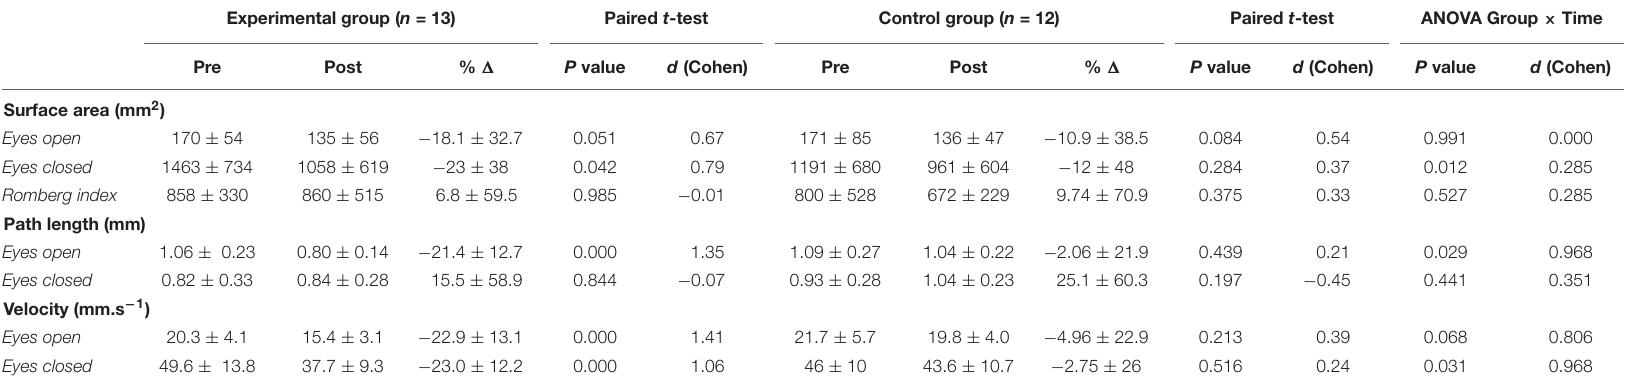
TABLE 5 | Dynamic balance in medio-lateral plane before and after intervention.